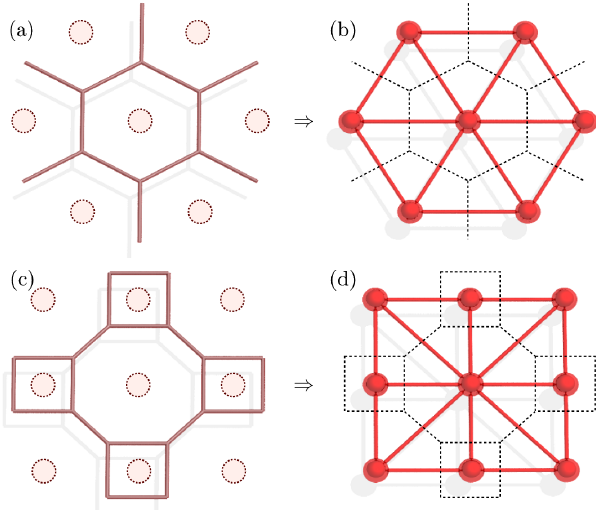
FIG. 3. For the hexagonal arrangement, there is a stabilizer operator Z 6 for each of the hexagon plaquettes (a). In the mapping, these stabilizer operators translate to classical Ising spins, which are placed on the dual lattice [regular triangular lattice, (b)]. The square-octagonal setup (c) has wider computing capabilities because it allows for a larger class of quantum gates to be implemented. There are stabilizers Z 4 ( Z 8 ) on the rectan- gles (octagons). The corresponding dual lattice in the mapping is the union-jack lattice